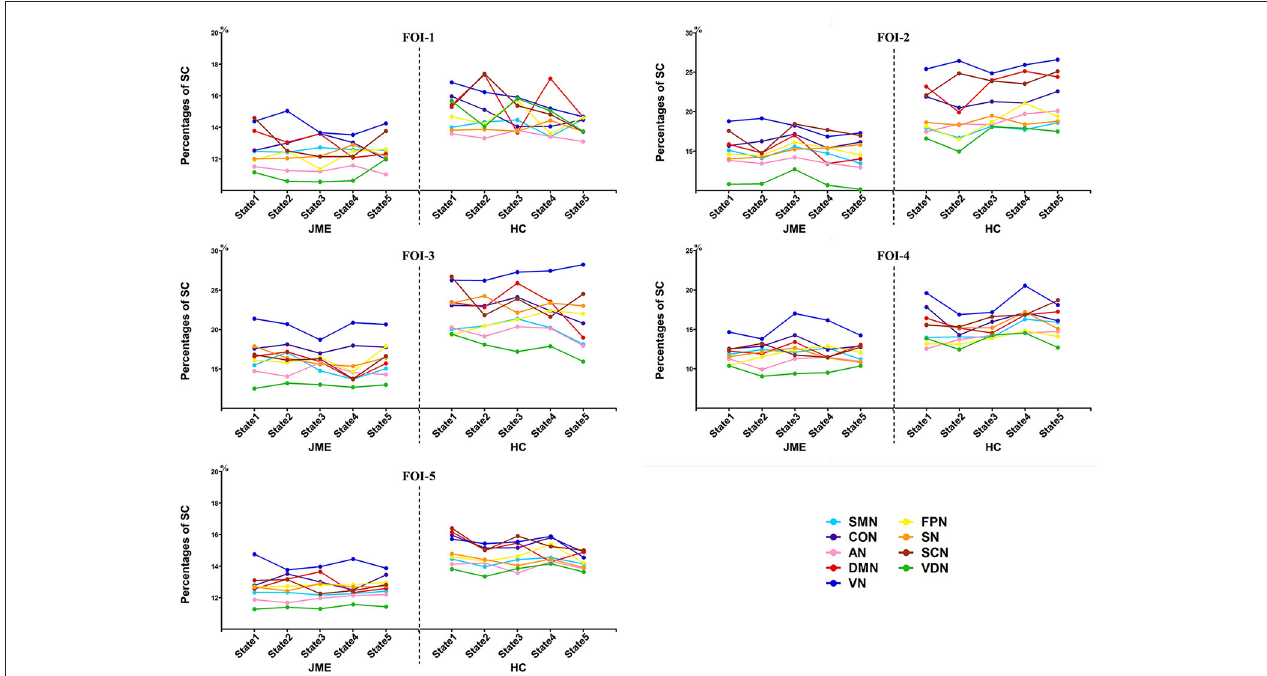
FIGURE 3 | The percentages of SC within RSNs in each state across different frequency